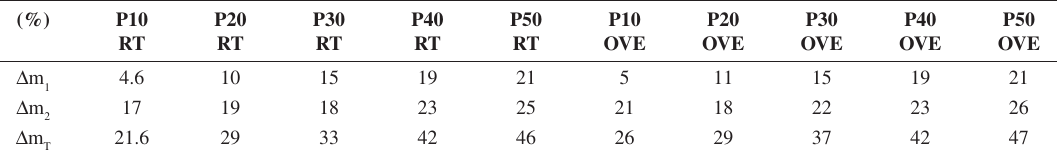
Table 4. Loss of mass during calcination and product